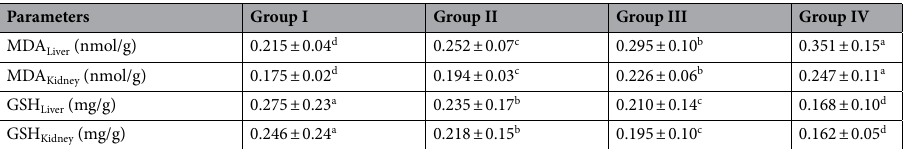
Table 3. Effects of cypermethrin on selected biochemical and oxidative stress parameters. *Group I: control, Group II: 62.5 mg/kg b.w cypermethrin, Group III: 125 mg/kg b.w cypermethrin, Group IV: 250 mg/kg b.w cypermethrin. MDA: malondialdehyde, GSH: glutathione. Values are shown as mean ± SEM (n = 6). Data were analyzed with SPSS computer program using Duncan test and ANOVA variance analysis. The averages shown with different letters (a–d) on the same line are statistically significant ( p < 0.05).